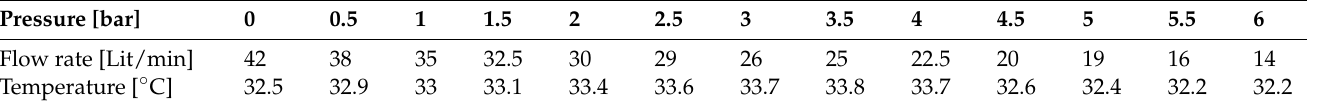
Table 3. The experimental